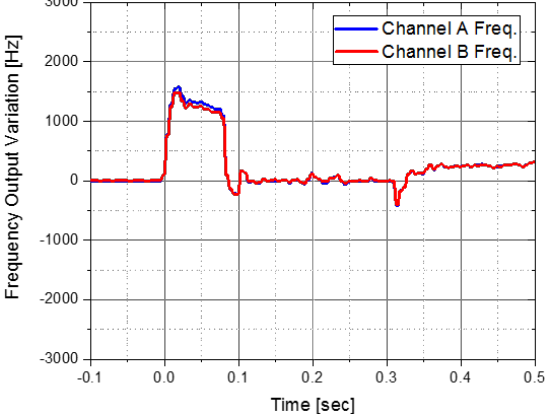
Figure 12. Accelerometer frequency output from IMU with brass integrated isolator.